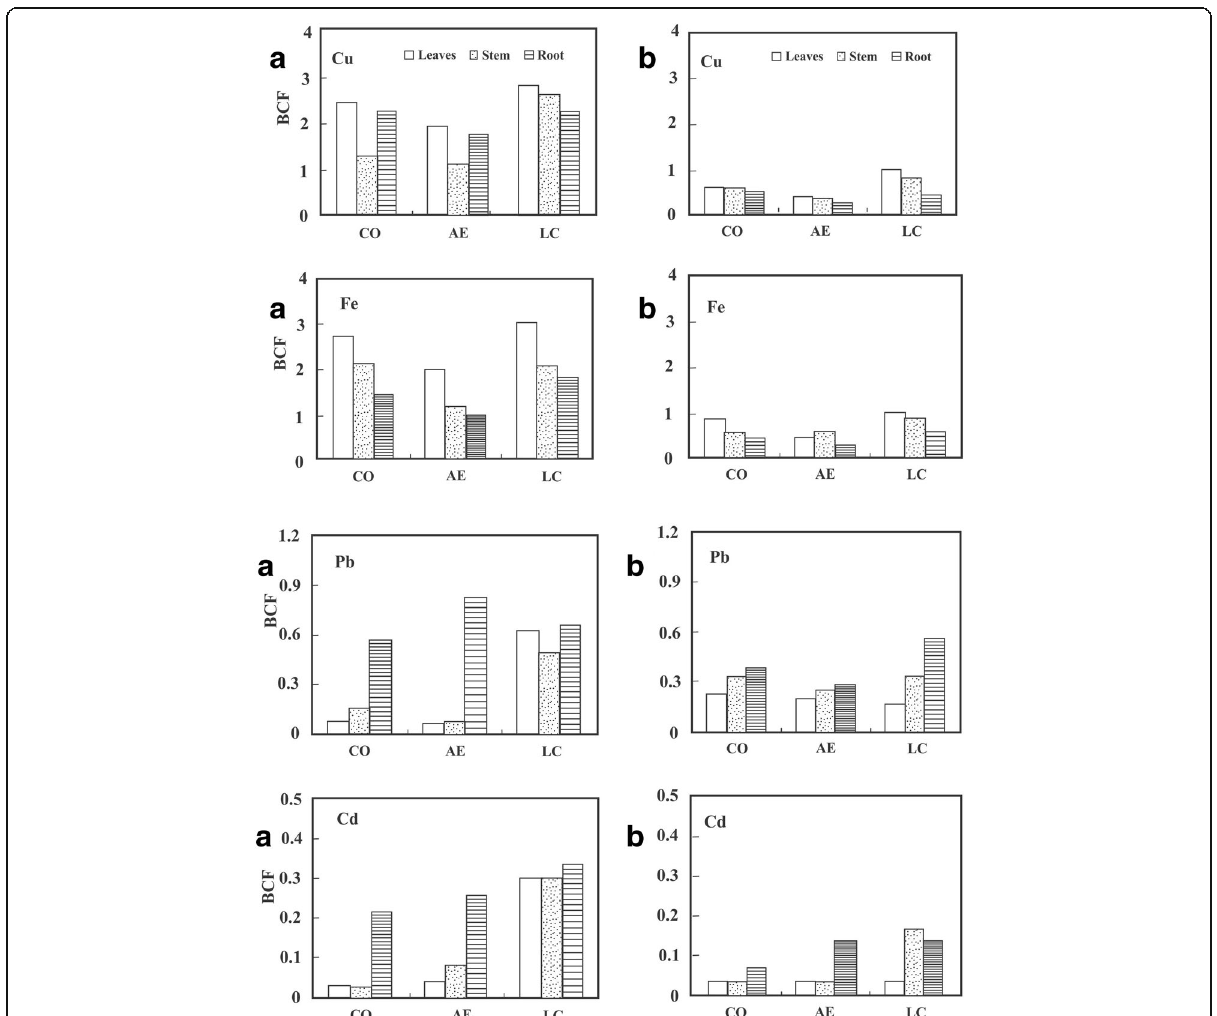
Fig. 3 Bioconcentration factors of Cd, Cu, Fe, Pb for Athyrium esculentum (AE), Chromolaena odorata (CO) and Lantana camara (LC) for a roadside sample, and b control